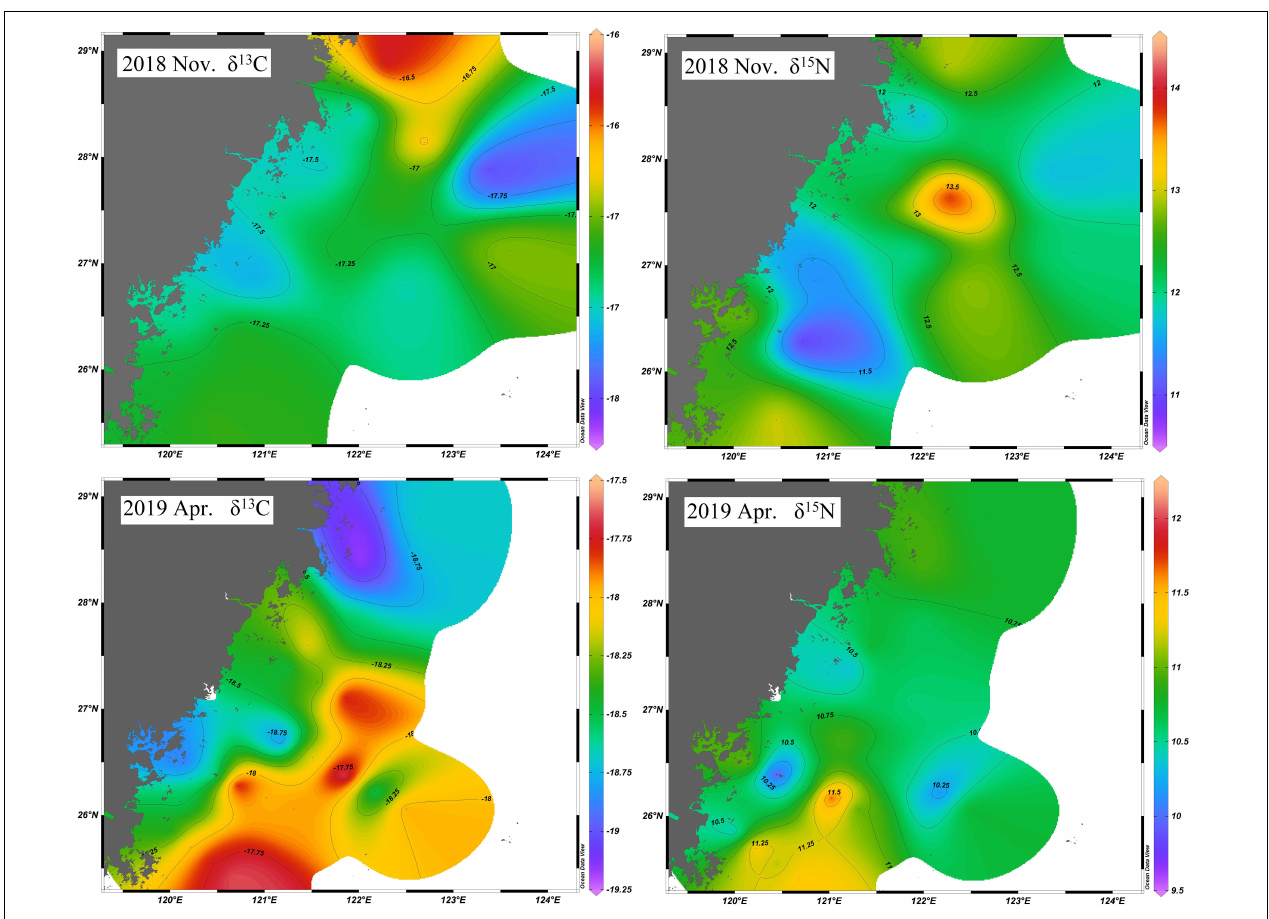
FIGURE 3 | δ 15 N and δ 13 C isoscape of Bombay duck in scECS.